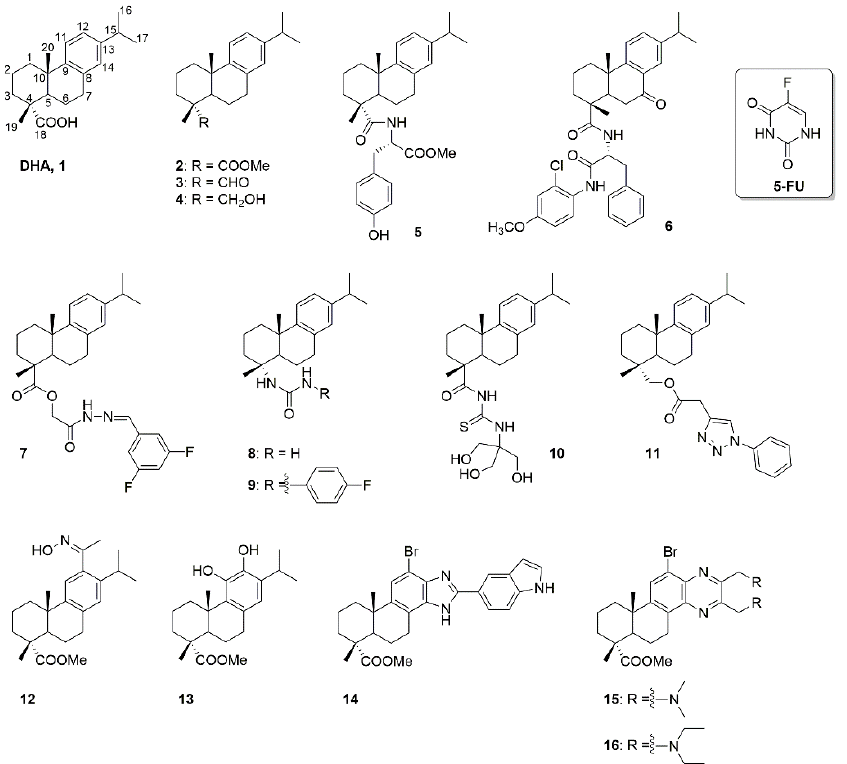
Figure 1. Structures of DHA ( 1 ) and its analogues ( 2 – 16 ) with anticancer